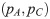
Results from two-pass experiments with model observers.In panels (a), (b), and (c) the filled circles show proportion correct and proportion of consistent responses for simulated internal-to-external noise ratios of 0, 1, and 2, respectively. Red symbols show results for the VPPM observer and green symbols show results for the MAP observer. For reference, blue lines in panels (a), (b) and (c) show the (pA,pC) contours for MAP observers with internal-to-external noise ratios of 0, 1, 2, 4, and the limit where internal noise dominates external noise (∞). Panel (d) replots data from the first three panels, showing the apparent internal-to-external noise ratio as a function of proportion correct. In panel (d), circles, diamonds, and squares show results for simulated internal-to-external noise ratios of 0, 1, and 2, respectively.